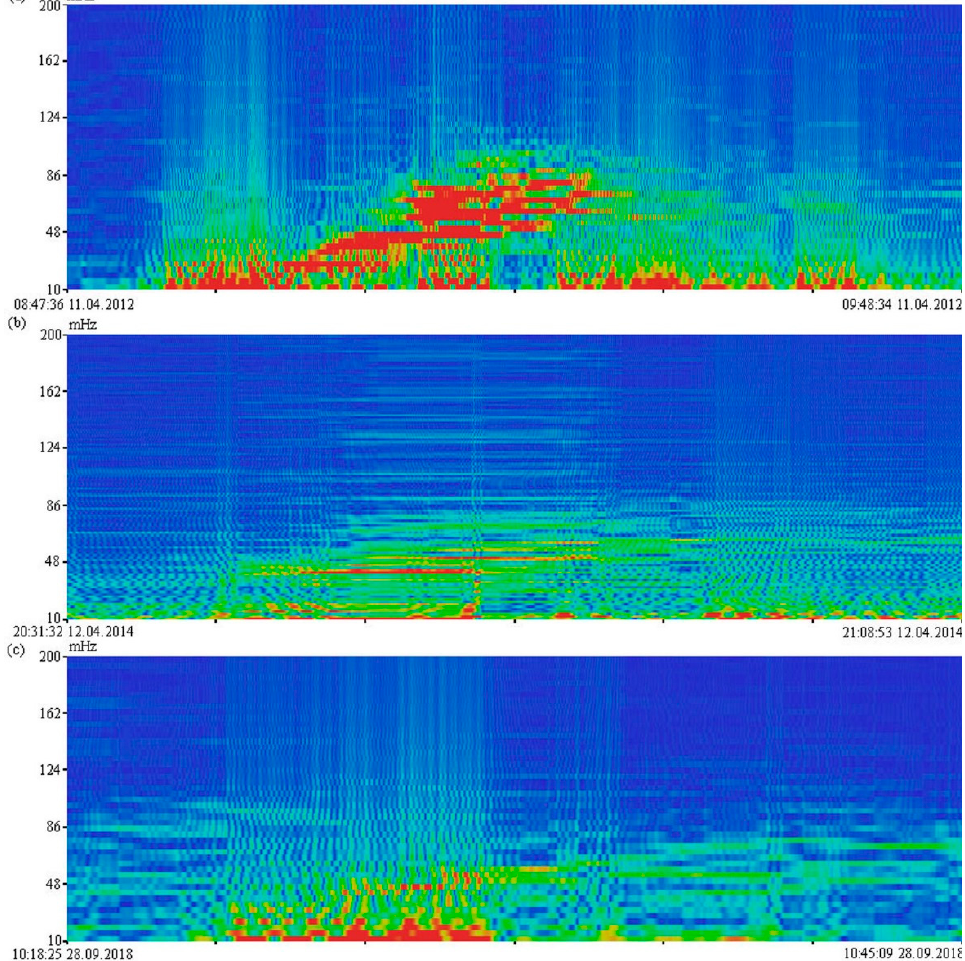
Figure 4. Dynamic spectrograms of 52.5 m laser strainmeter recordings from April 2012 ( a ), April 2014 ( b ), and September 2018 ( c ).